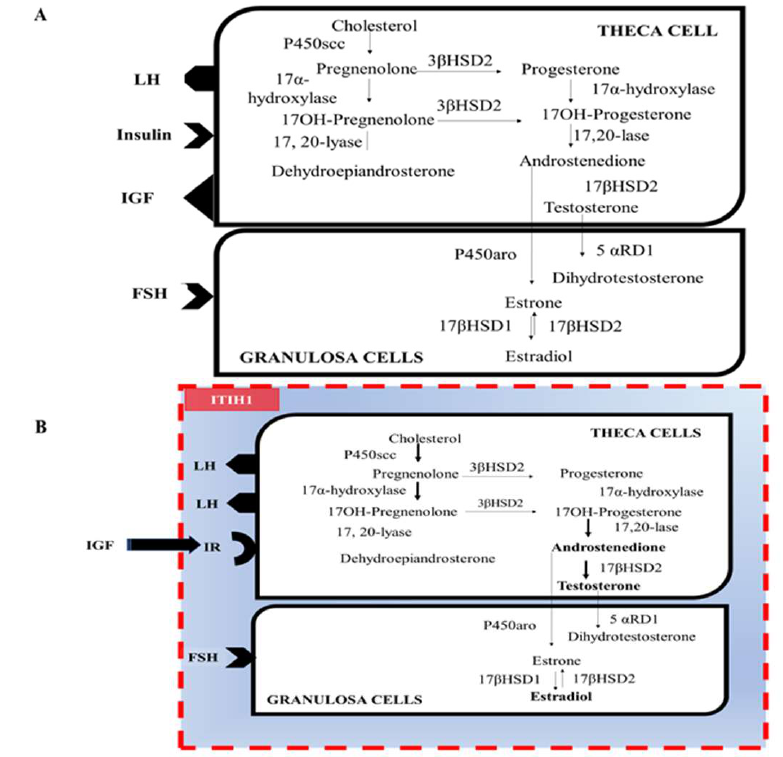
Figure 2. Binding hormonal ligands to the receptors in ovarian cells and hypothetical ITIH1 interference. ( A ) The bindings of LH, insulin, IGF, and FSH to the cell surface membrane-bound receptors in ovarian cells. ( B ) The potential effect of ITIH1 on ovarian cells. Reduced levels of G α 13 in the liver lead to the hypersecretion of ITIH1 from the liver. Circulating ITIH1 may travel to the ovarian theca and granulosa cells. The binding of ITIH1 to HA on the cell surface may prevent insulin from binding to its receptors. Abbreviations: LH, luteinizing hormone; IGF, insulin-like growth factor; FSH, follicular stimulating hormone; ITIH1, inter-alpha-trypsin inhibitor heavy chain H1; and HA, hyaluronic acid.